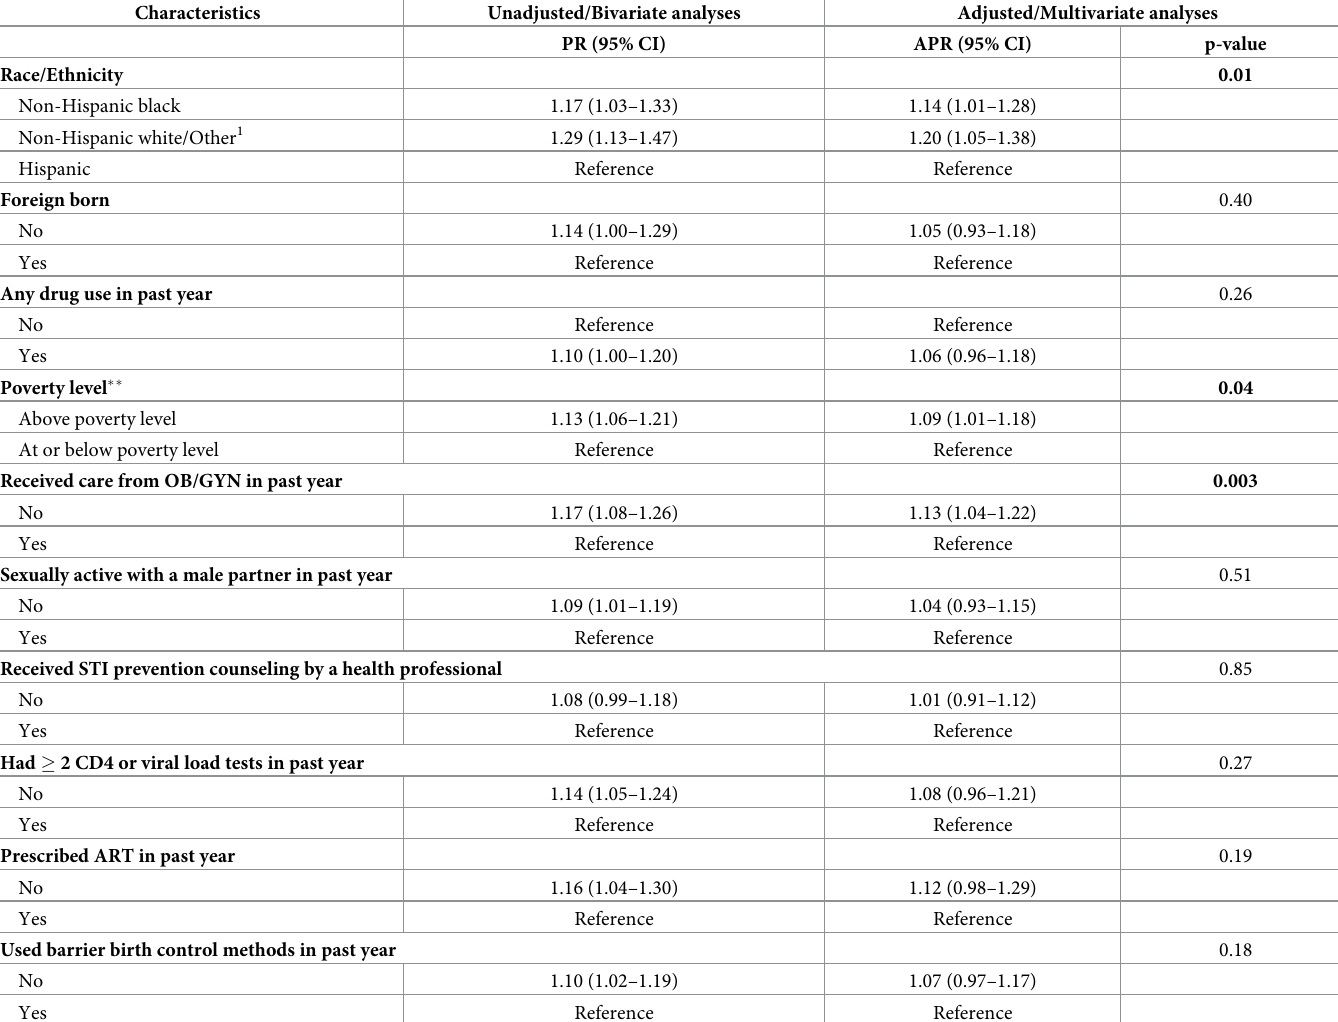
Table 2. Associations between selected characteristics and having had (cid:21) 1 unplanned pregnancy among HIV-positive women in care—Medical Monitoring Project, 2013–2014 (N =